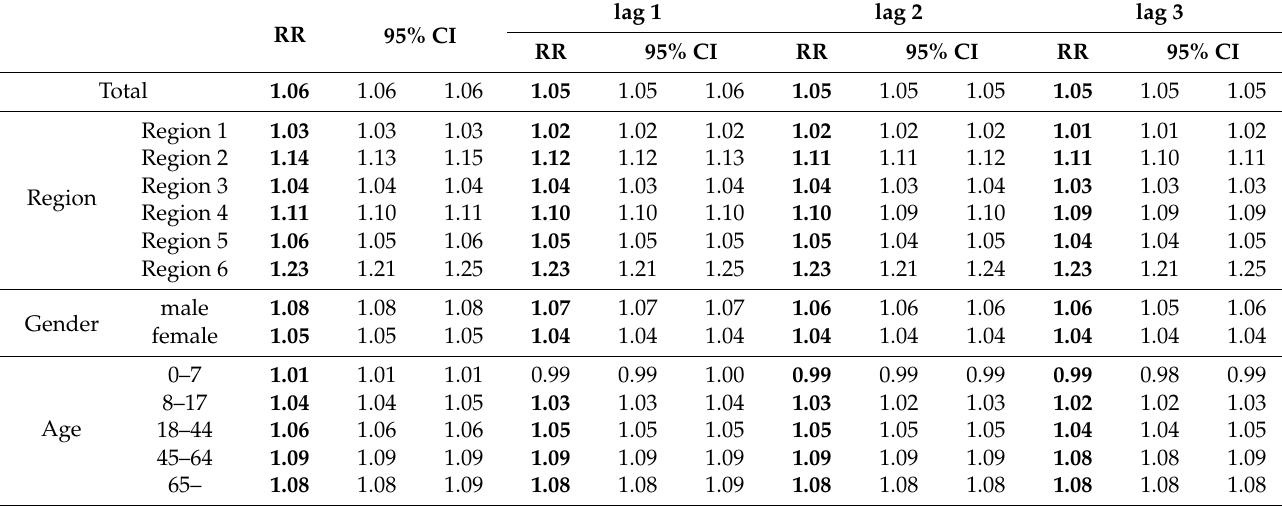
Table 4. Estimated relative risk of incidence for every 1 ◦ C increase above 29.5 ◦ C from May through September from 2002 to